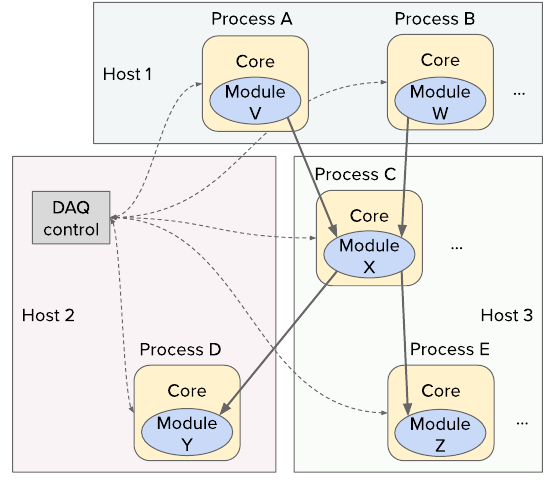
Figure 1. Example scheme of the main elements distributed on multiple hosts.